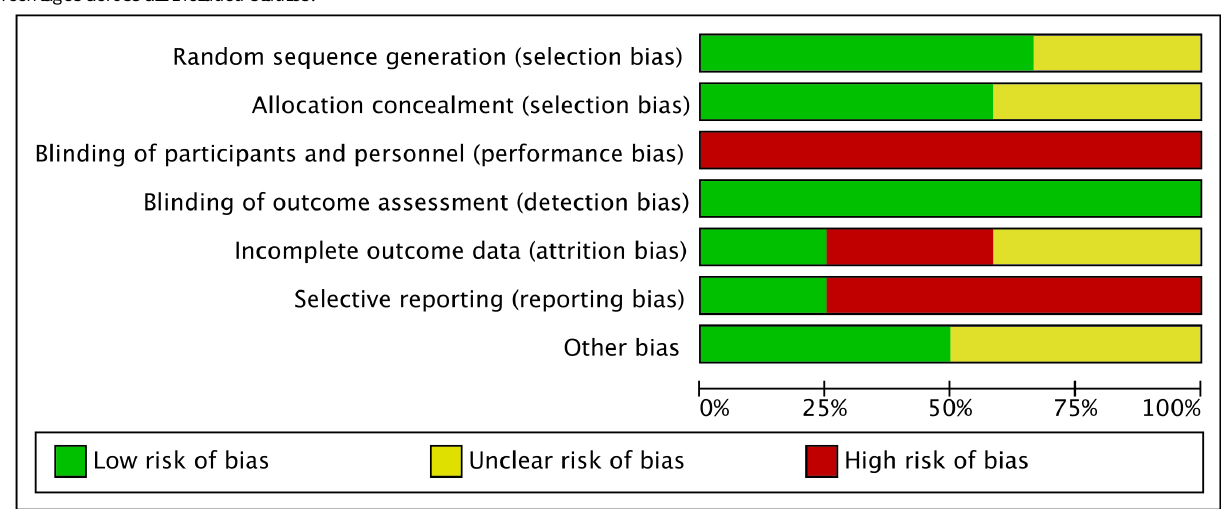
Figure 2. Risk of bias for the primary outcome (hemoglobin A 1c changes): review authors’ judgments about each risk-of-bias item presented as percentages across all included studies.